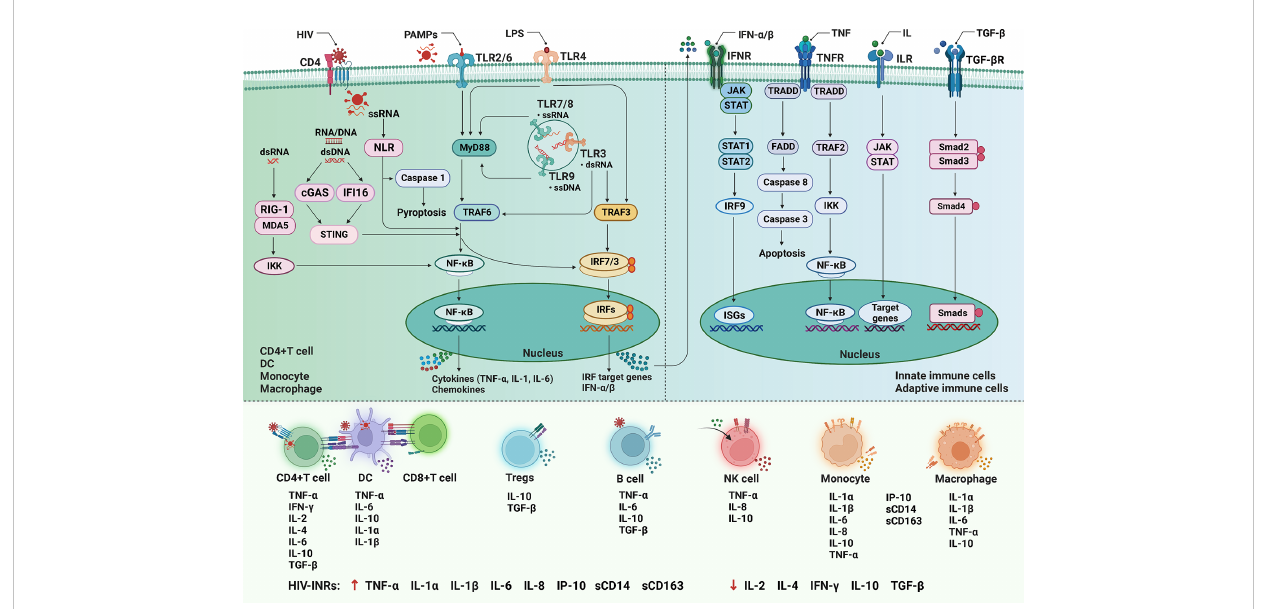
FIGURE 3 The cytokine signaling in HIV infection. After HIV infection, the pathogen-associated molecular patterns (PAMPs) are sensed by the pathogen- recognition receptors (PRRs) to trigger the innate immune response. Among them, the Toll-like receptors (TLRs) signal transduction pathways mainly include myeloid differentiation primary response gene 88 (MyD88) dependent and independent pathways. In the former, TLRs combine with MyD88 to recruit tumor necrosis factor (TNF) receptor-associated factor (TRAF)-6, and activate nuclear factor (NF)- k B and IFN regulatory factor (IRF)-7, induce the expression of pro-in fl ammatory factors and type I interferons (IFN-I); in the latter, TLRs sense HIV products and recruit TRAF3 and TRAF6, then activate NF- k B and IRF3. The nucleotide-binding oligomerization domain-like receptors (NLRs) can sense single-stranded RNA (ssRNA), and can also interact with caspase-1 to induce pyroptosis. The RIG-I-like receptors (RLRs) can sense the double-stranded RNA (dsRNA) to recruit I k B kinase (IKK) and activate NF- k B and IRF-3. The cyclic GMP/AMP synthase (cGAS) and IFN-inducible protein 16 (IFI16) can bind to double-stranded DNA (dsDNA), then activate the stimulator of interferon genes (STING) signal pathways. Initiation of the innate immune response produces a variety of soluble factors that recruit and activate innate immune cells. In addition, IFN-I, TNF, interleukin (ILs), and transforming growth factor (TGF)- b respectively bind to cell surface receptors and activate downstream signaling pathways to participate in immune regulation. LPS, lipopolysaccharide; MAD5, melanoma differentiation-associated protein 5; JAK-STAT, Janus kinase and signal transducer and activator of transcription proteins; ISGs, interferon-stimulated genes; TRADD, TNF receptor 1 (TNFR1)-associated death domain protein; FADD, Fas-associated protein with death domain; DC, dendritic cell; NK, natural killer cell; INRs, immunological